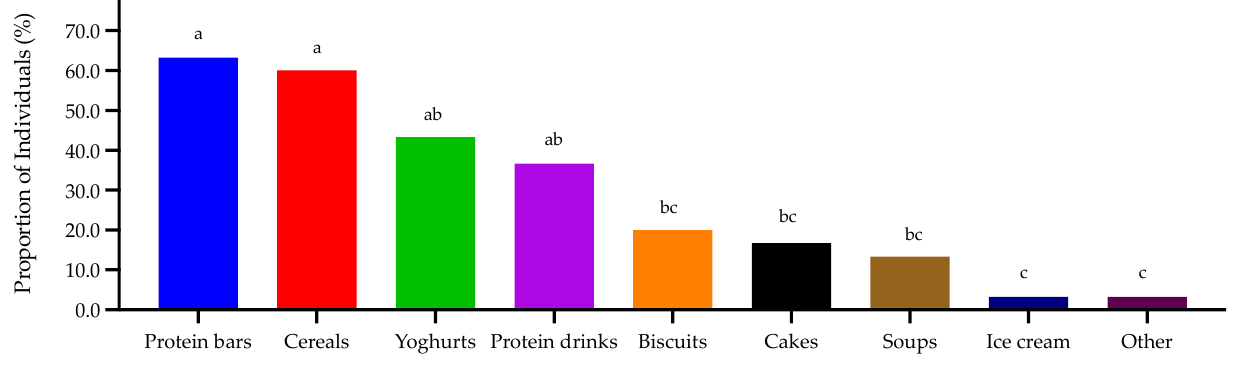
Figure 7. Consumers commonly consumed protein-fortified products ( n = 30; consumers only answered this question if they regularly consume protein-fortified products). Data expressed as percentages with differing small letters reflecting significance from post hoc analysis.